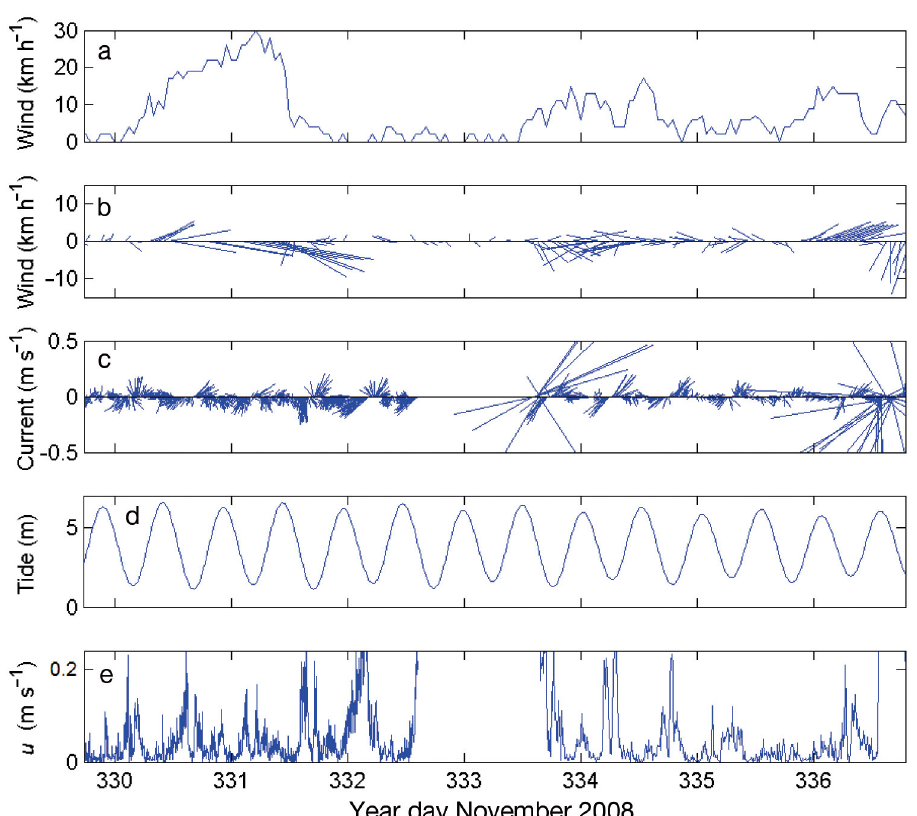
Fig. 2. Forcing conditions at the study site from year day 330 to 336, which extends from 25 November to 1 December 2008. (a) Wind speed, (b) wind speed and direction; positive values are winds from the south. (c) Current speed and direction at the site, with positive values indicating a flow from south to north. (d) Predicted tide at Back Bay, which is immediately adjacent to Charlie Cove. (e) Velocity 1 m above the